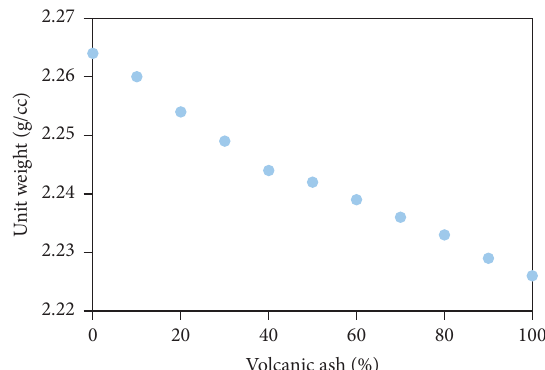
Figure 4: Impact of VA on the density of HMA.